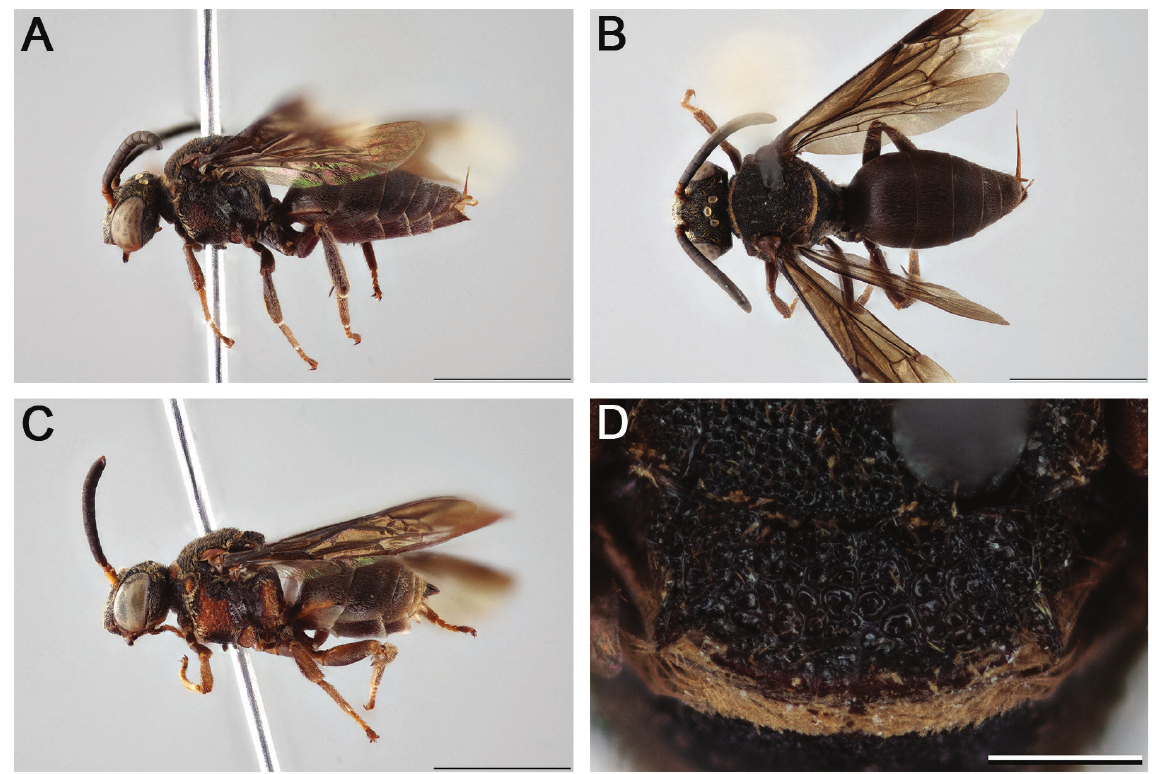
Fig. 15. Epeolus niger (Michener, 1954). A . Female, habitus, lateral view. B . Female, habitus, dorsal view. C . Male, habitus, lateral view. D . Female axillae and mesoscutellum, dorsal view. Scale bars: A–C = 3 mm; D = 0.5